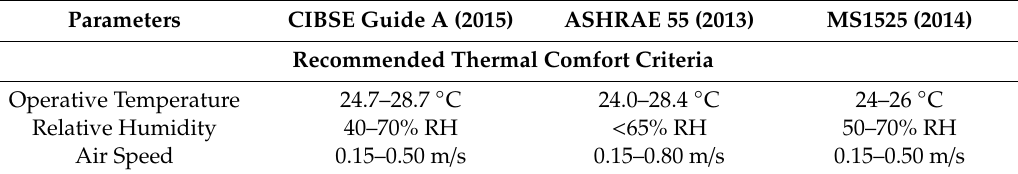
Figure 9. Kuala Lumpur’s comfort zone on the psychrometric chart. Table 2. Parameters, ranges and limits for fieldwork